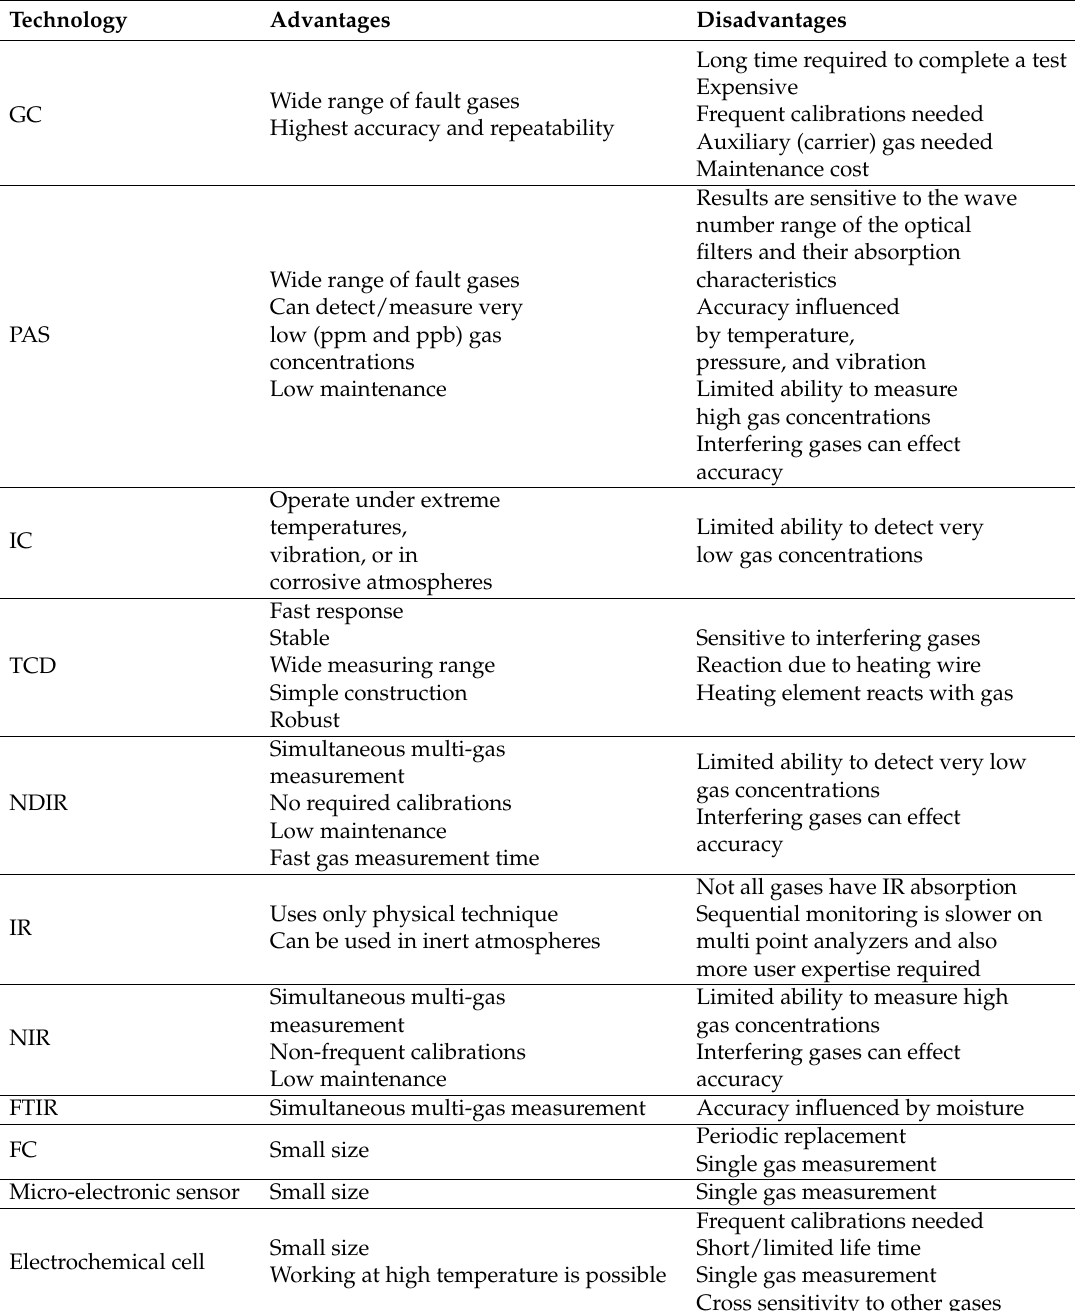
Table 5. Advantages and disadvantages of gas detection technologies